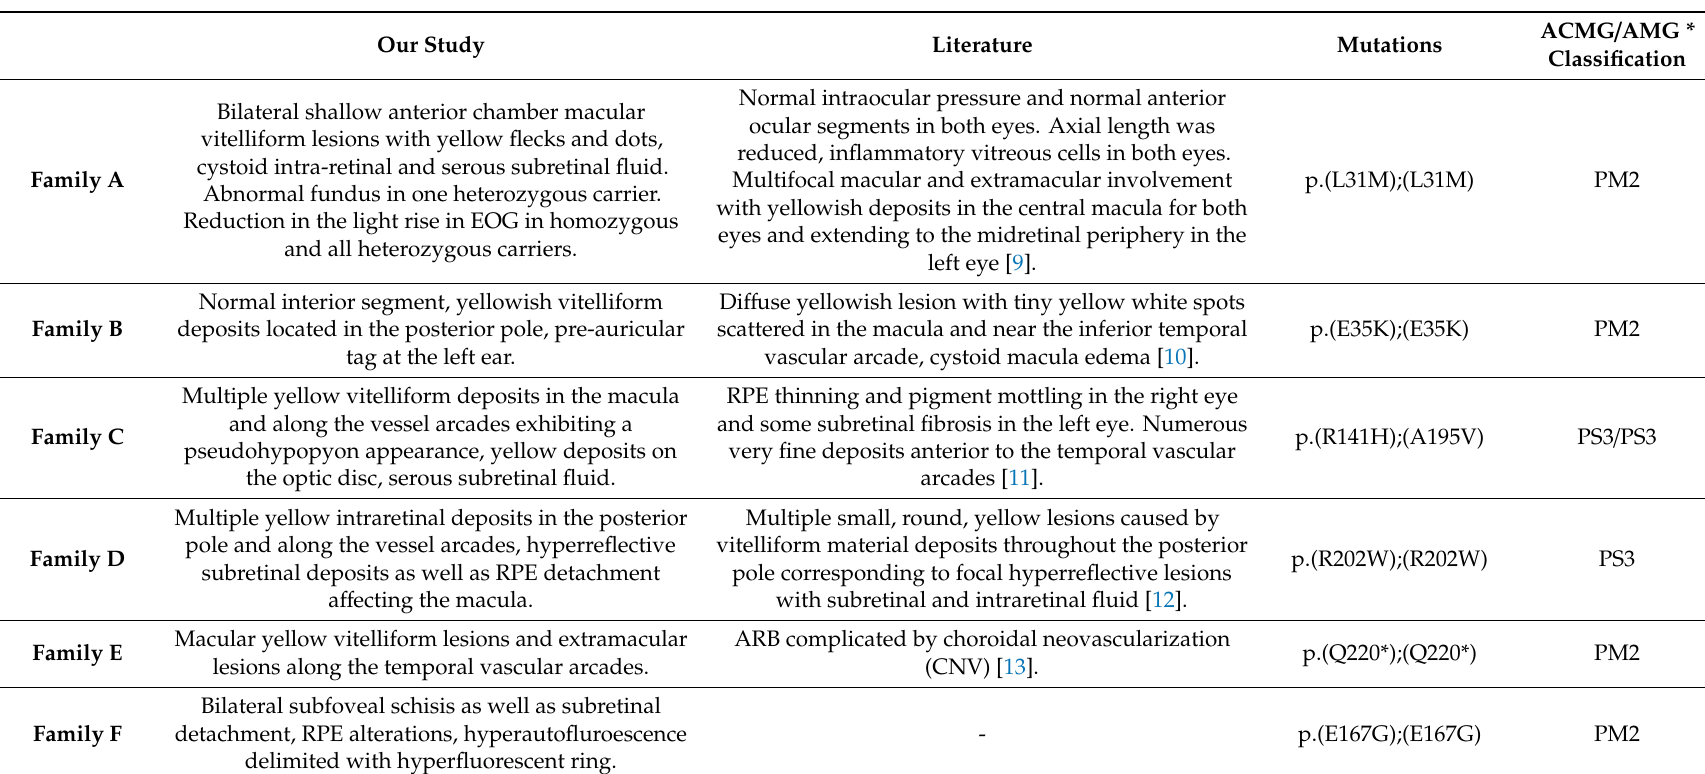
Table 2. Comparing the phenotype of our families with the reported individual harboring the same mutant